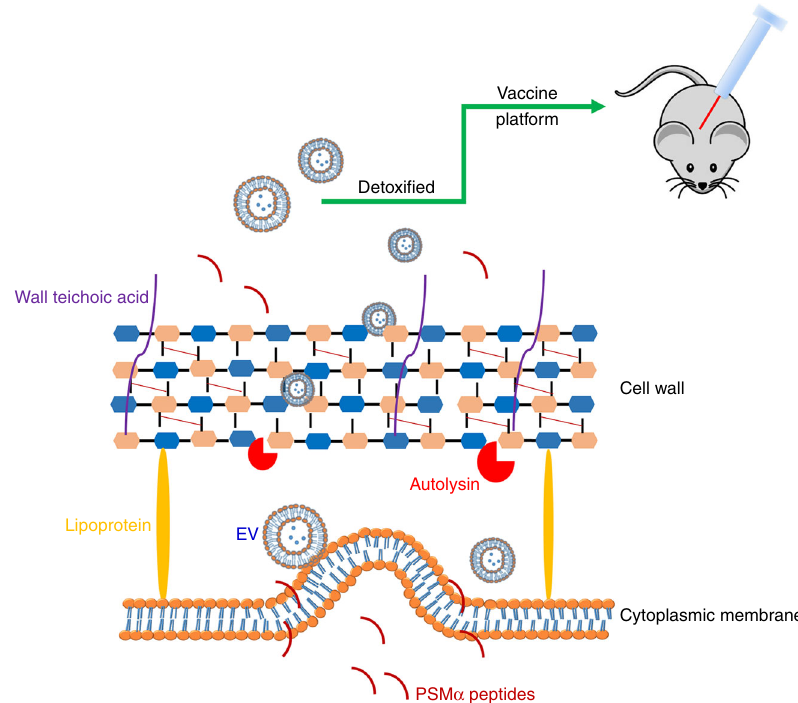
Fig. 7 Proposed mechanisms underlying EV production by Staphylococcus aureus . EVs are generated from the cytoplasmic membrane, and this process is promoted by S. aureus PSM α peptides, which have surfactant-like activity, causing membrane disruption. Membrane-derived EVs must also traverse the highly cross-linked S. aureus peptidoglycan barrier, and the extent of cell wall cross-linking modulates the ef fi ciency of EV production. Autolysins, such as Sle1, facilitate EV release by hydrolyzing peptidoglycan, particularly at sites of active cell division. We mutated S. aureus to render its EVs non-toxic, and then genetically engineered the mutants to package detoxi fi ed antigens in EVs. These recombinant EVs were immunogenic in mice and showed protective ef fi cacy in a sepsis model of S. aureus